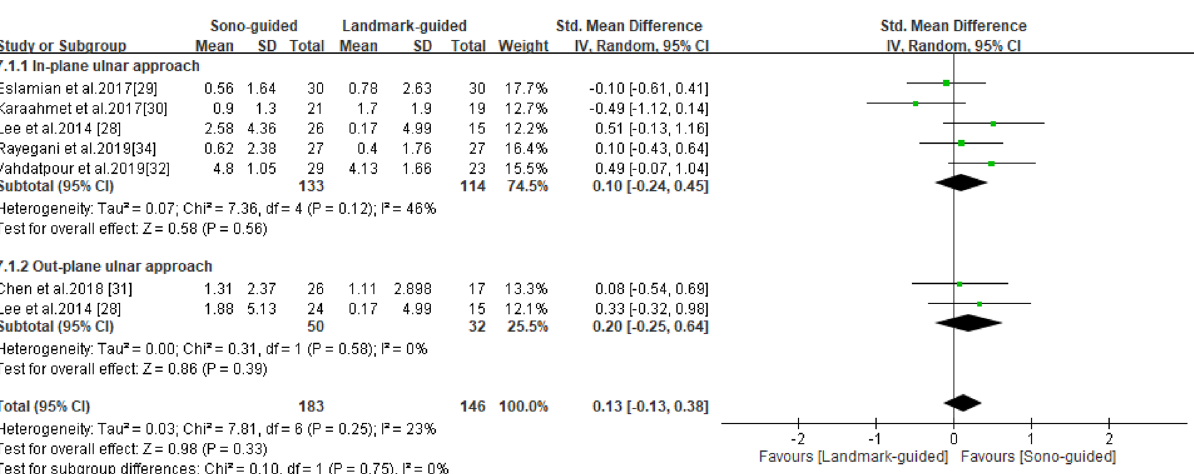
Figure 8. Forest plot for CMAP. US-guided, ultrasound guided; LM-guided, landmark